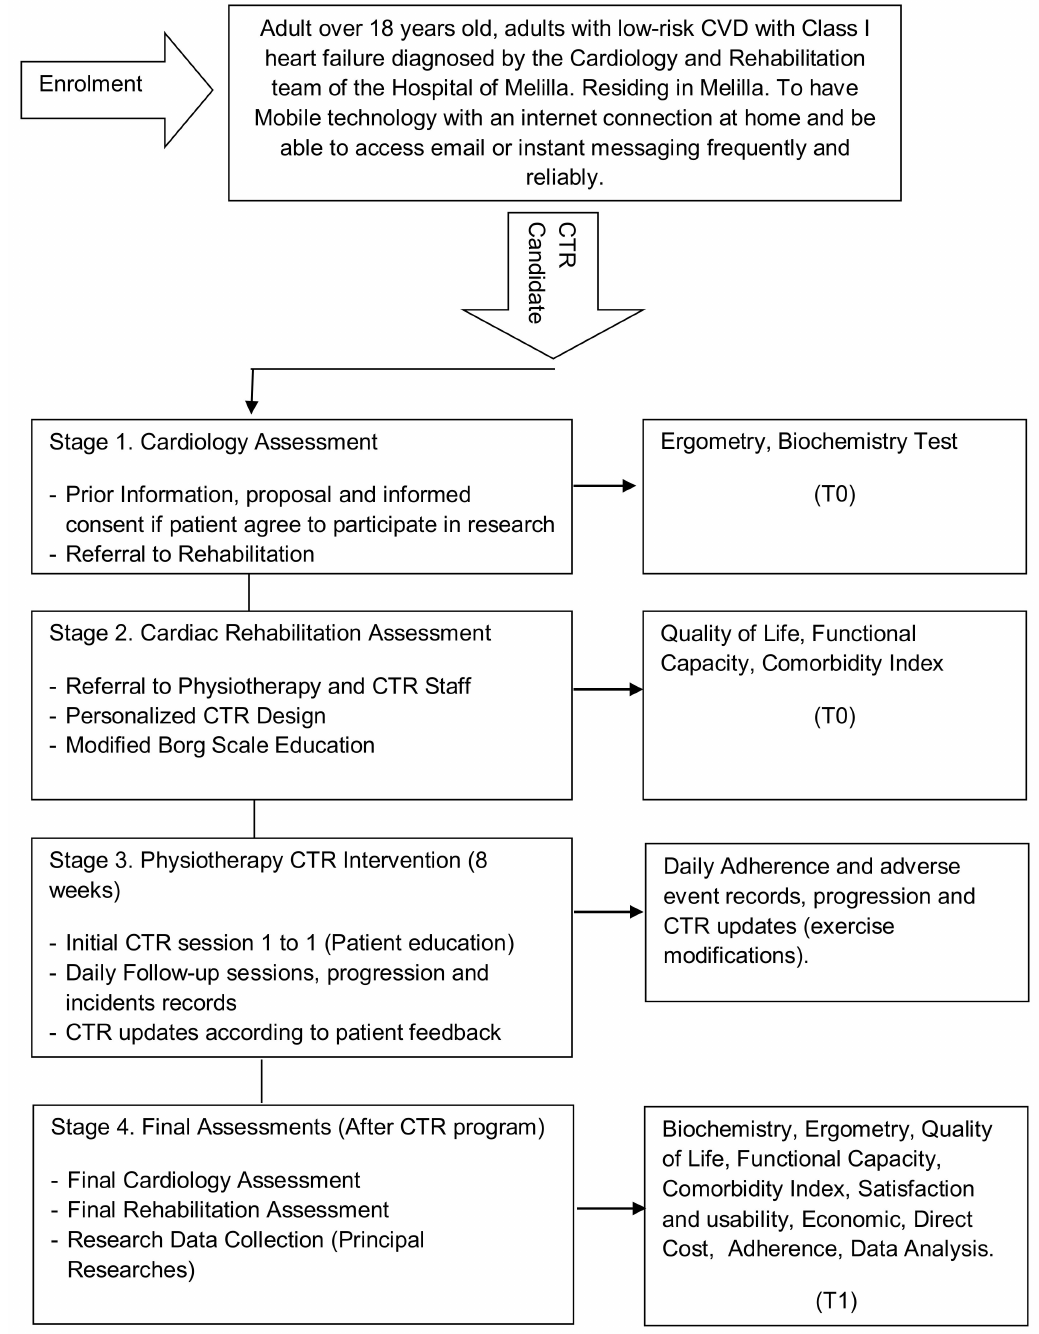
Figure 1. Study design. Abbreviations CVD, cardiovascular disease; CTR,